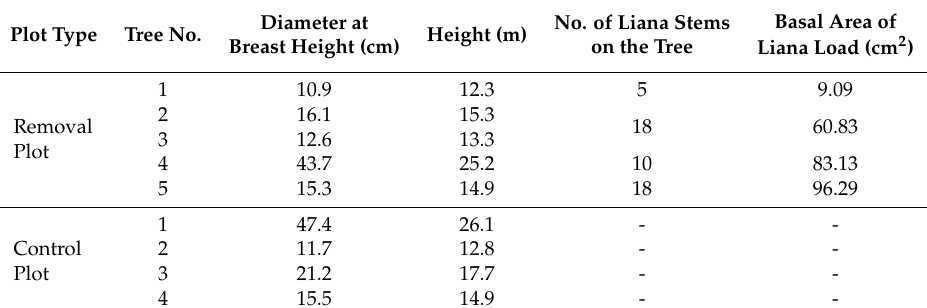
Table 1. Overview of trees, diameter and number of liana stems on each trees in the removal and control plot. Trees 2 and 3 are the same individual that branched below 1 m from the ground.